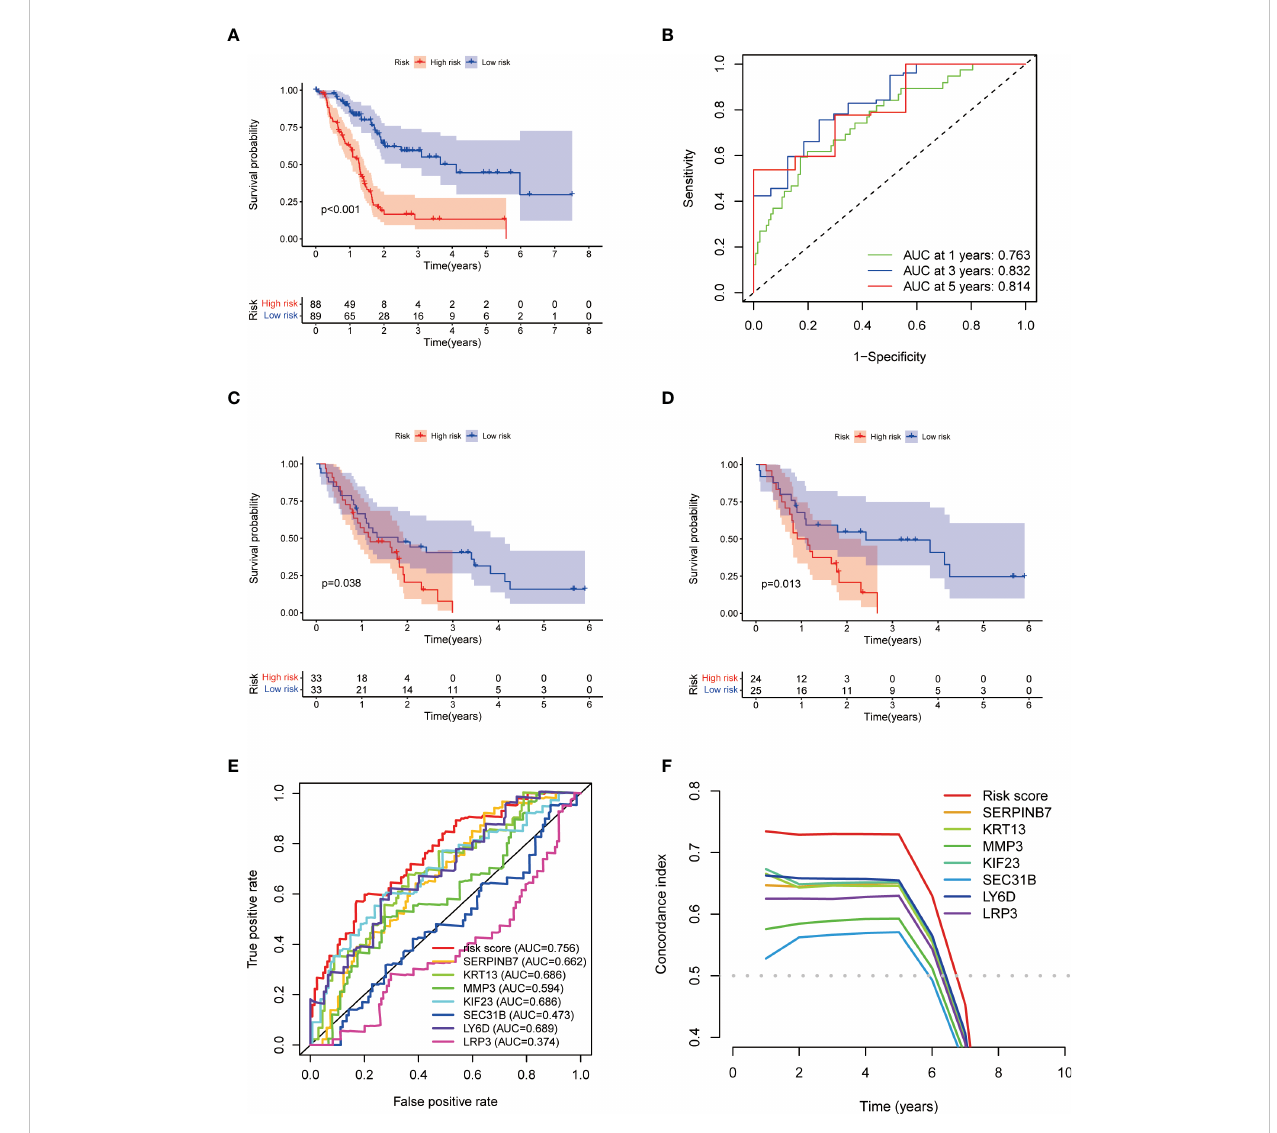
FIGURE 6 Construction and validation of HAPM. (A, B) KM-survival curve and ROC curve for the TCGA-PAAD dataset. (C, D) KM-survival curves of the GSE62452 and GSE78229 dataset (validation). (E, F) ROC curves and C-indices for HAPM and genes constructing HAPM